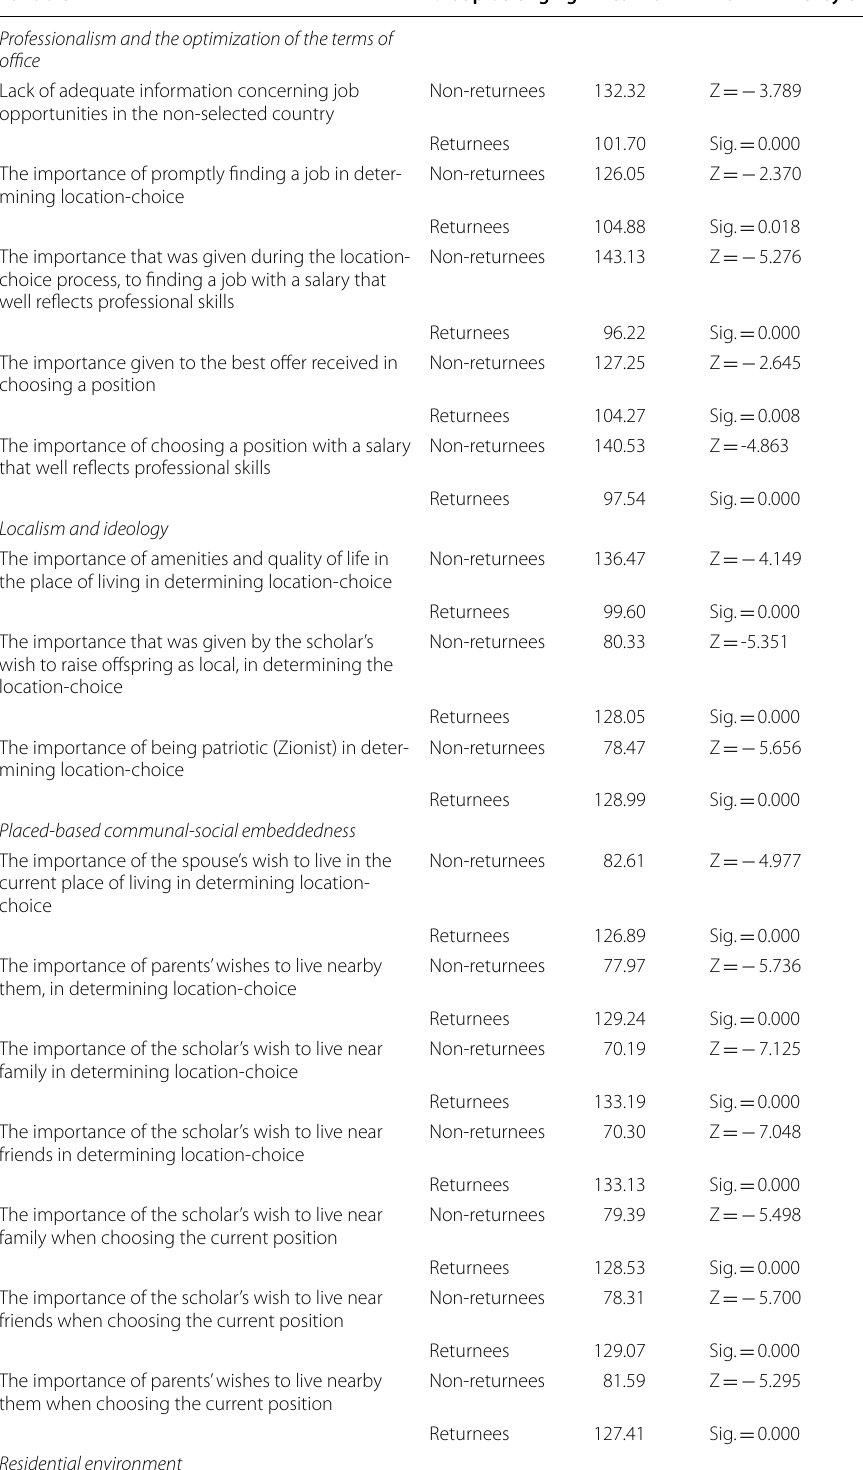
Table 2 Group differences between non-repatriating and repatriating scholars